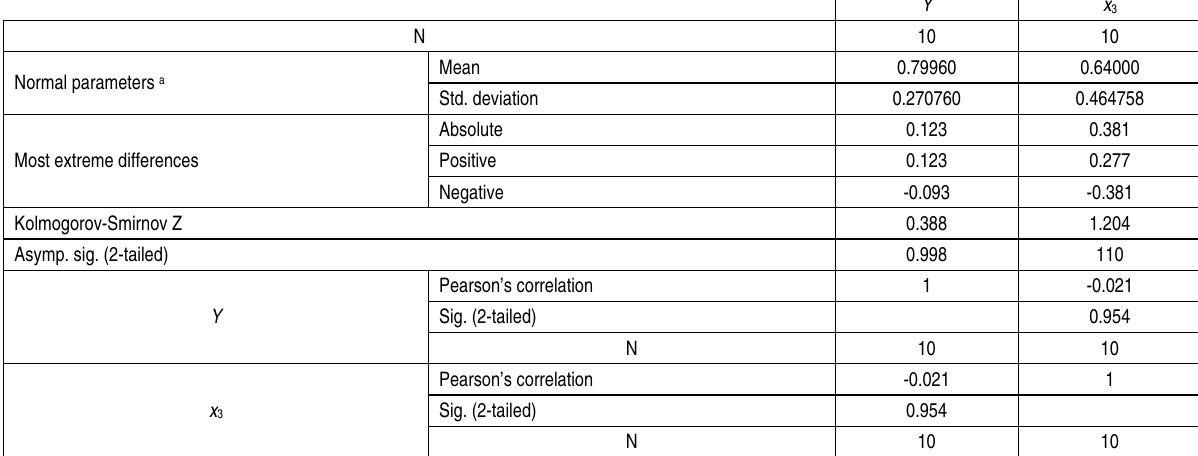
Table 15. The third hypothesis test result (normality test and correlation analysis)